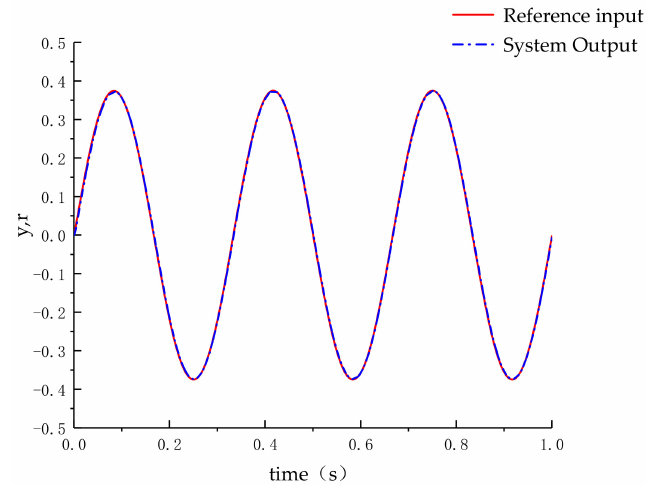
Figure 13. Sine signal following.